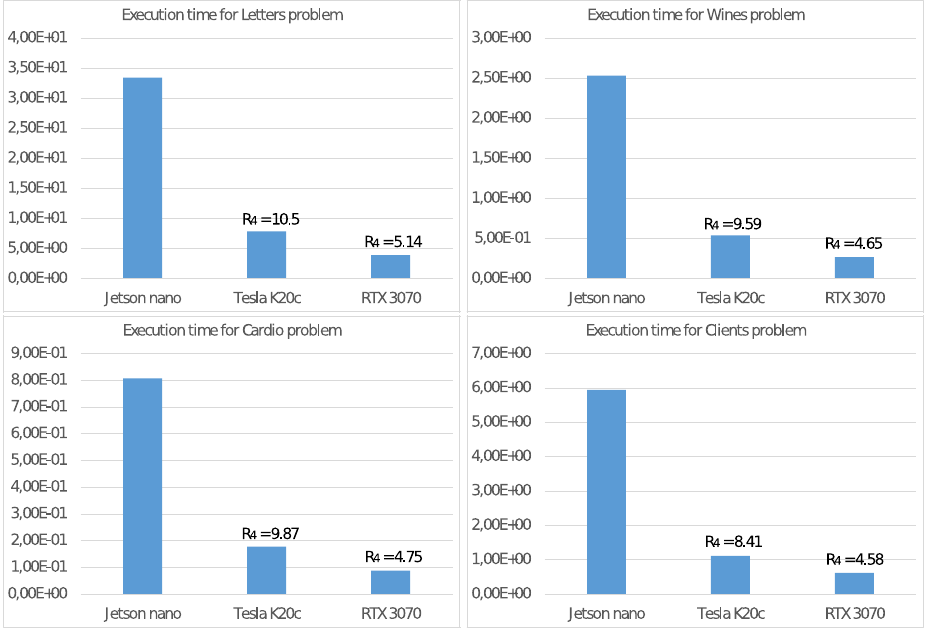
Figure 10. Execution time (in second) and energy consumption ratio R 4 of two other GPUs compared with the NVIDIA Jetson Nano